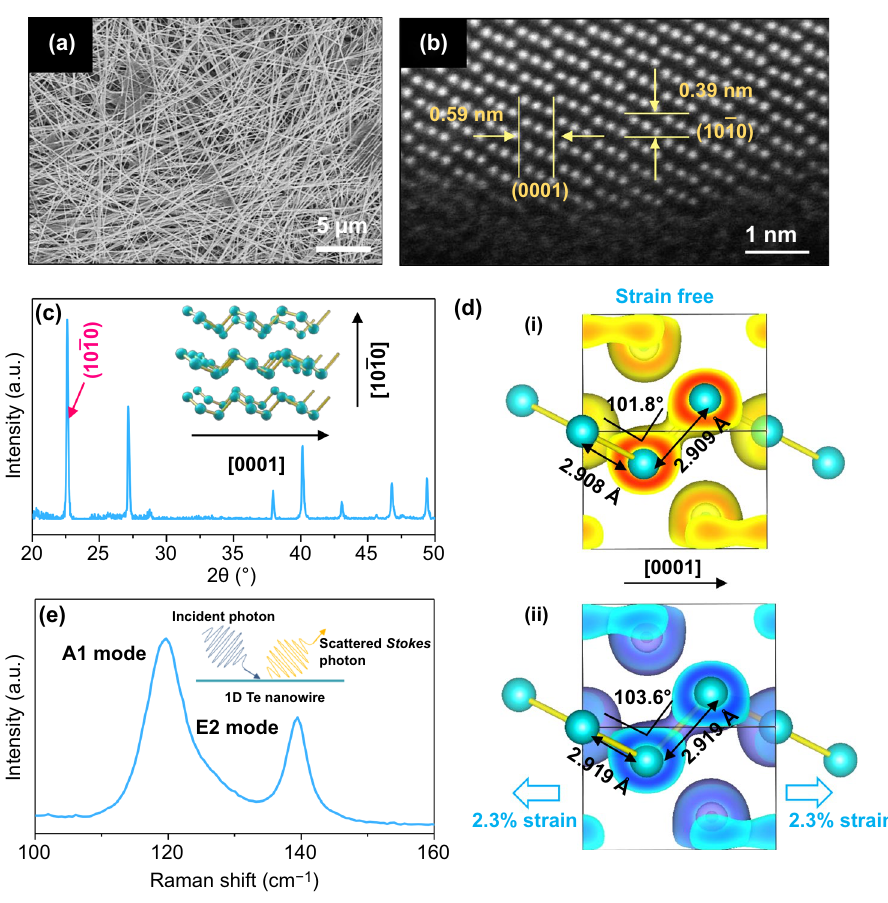
Fig. 1 Characterization of 1D Te nanowire. a Scanning electron microscopy (SEM) image of the as-synthesized 1D Te nanowire. b High-reso- lution transmission electron microscope image of the 1D Te nanowire at the edge. c XRD results of the 1D Te nanowire. d Atomic structures of the Te crystals without and with tensile strain. The isosurface value for electron density is 0.03 e /Bohr 3 , e Raman spectra of the 1D Te